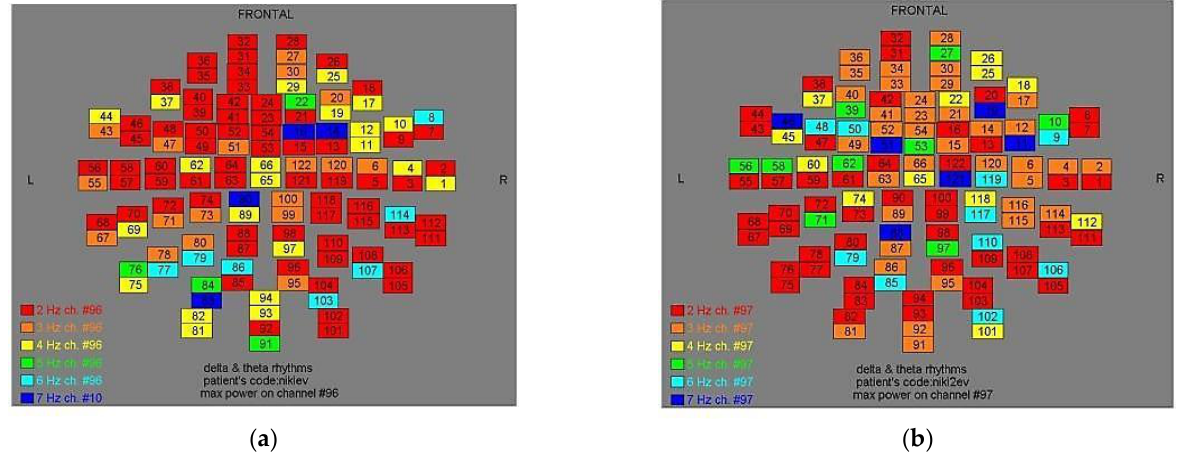
Figure 3. Dominant frequency color mapping for patient #2, before ( a ) and after ( b ) magnetic stimulation.